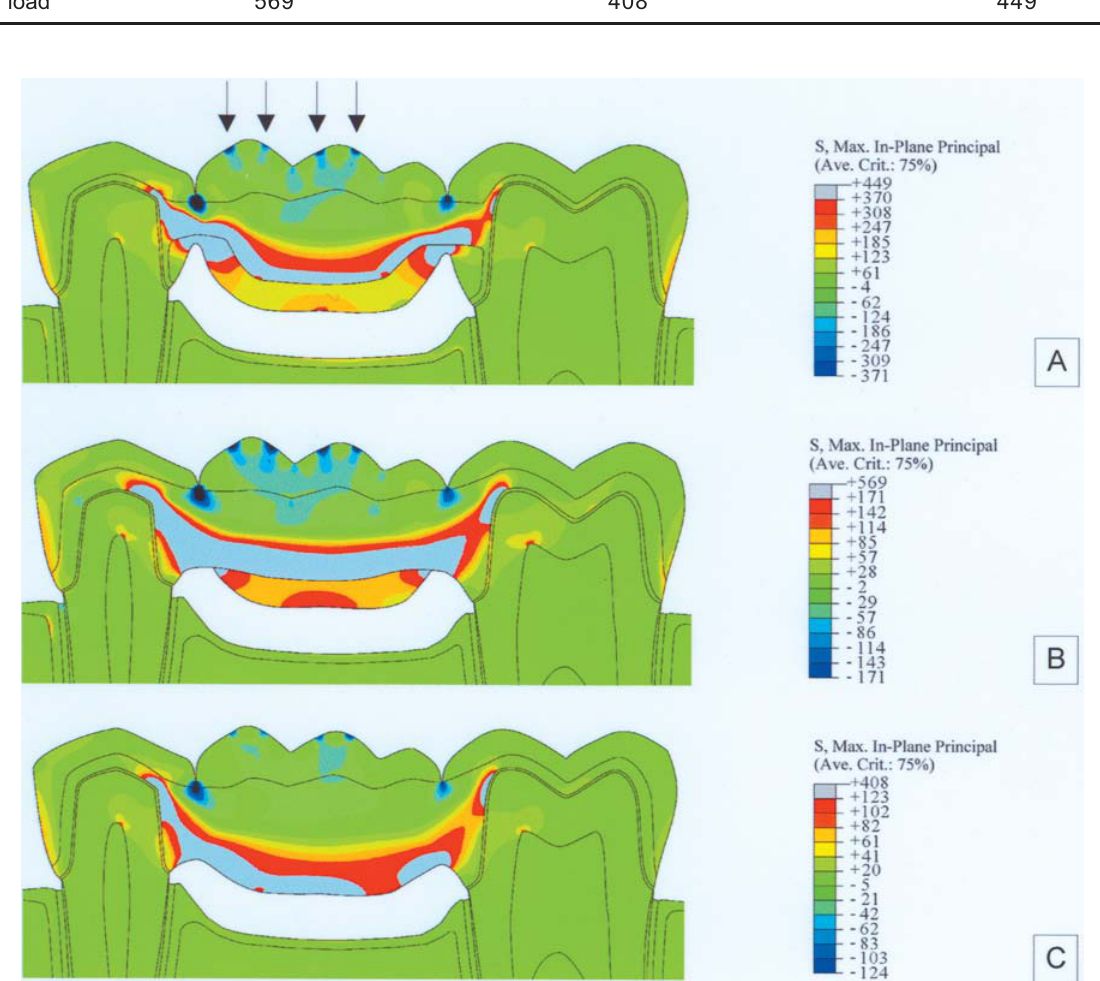
FIGURE 4- Stress distribution found when the load was applied only on the pontic. Models: (A) Metal-ceramic FPD; (B) All- ceramic-OC FPD; (C) All-ceramic-O FPD